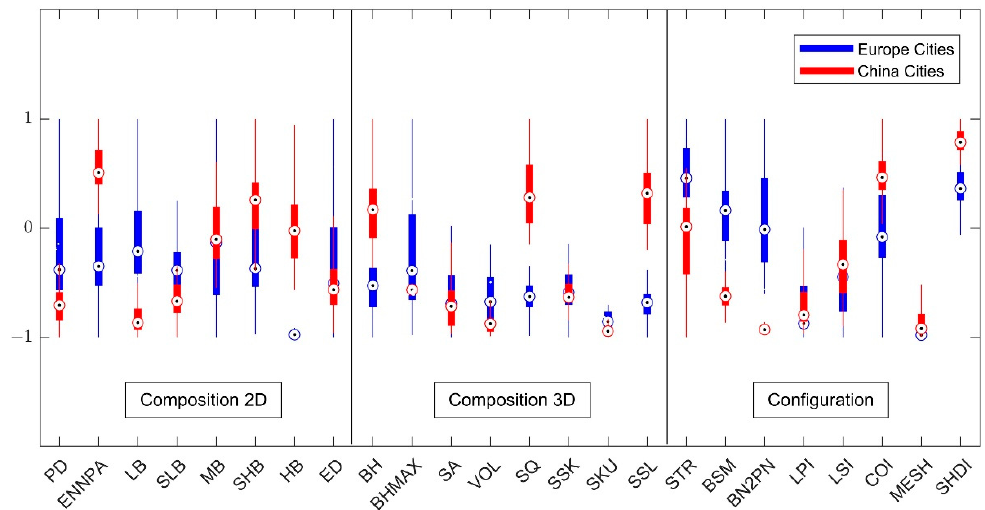
Figure 3. Results of 3D landscape metrics belonging to three groups. Red color represents Chinese cities, while blue color represents European cities.